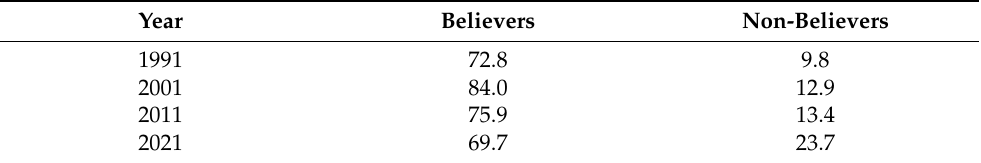
Table 1. Total number of believers and